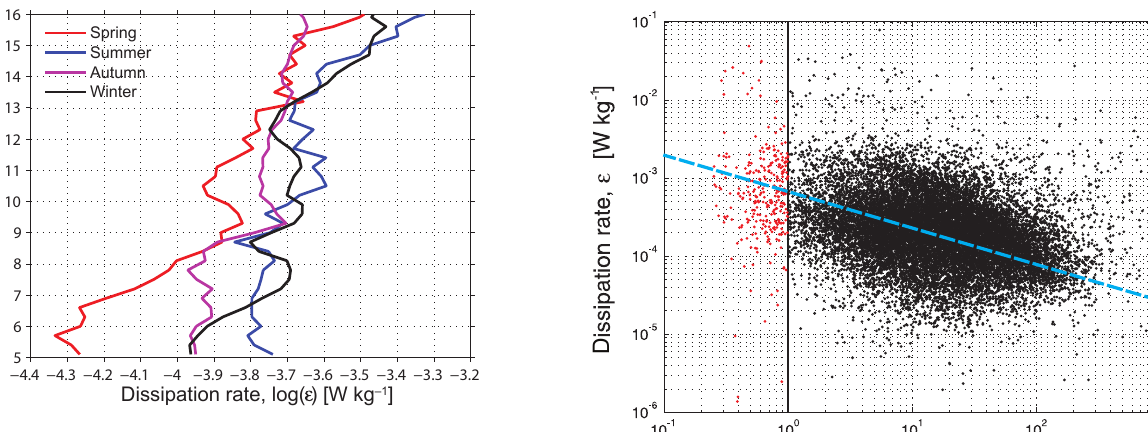
Figure 10. Vertical profiles of the seasonal medians of ε ob- served from the radar observations with MAARSY during differ-